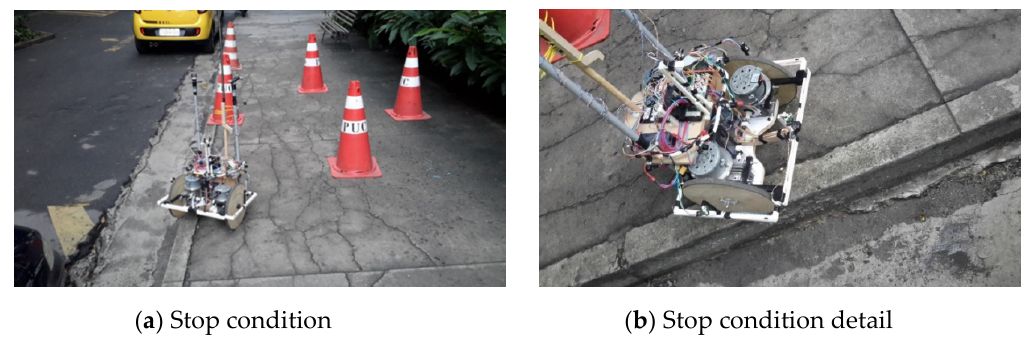
Figure 21. Stopped due to unsafe condition.